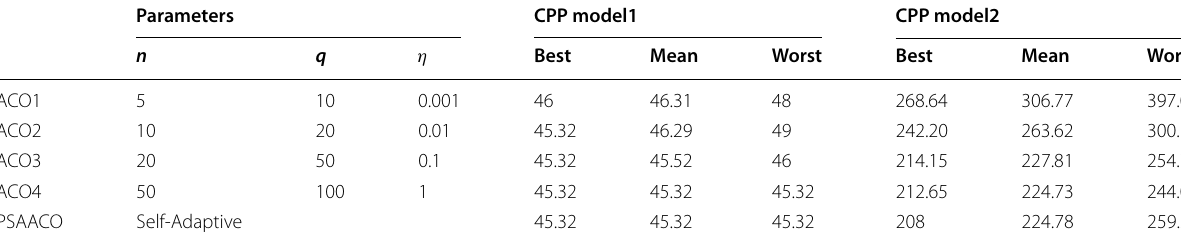
Table 6 Experiments for Performance Improvement using Self-Adaptive Parameters Parameters